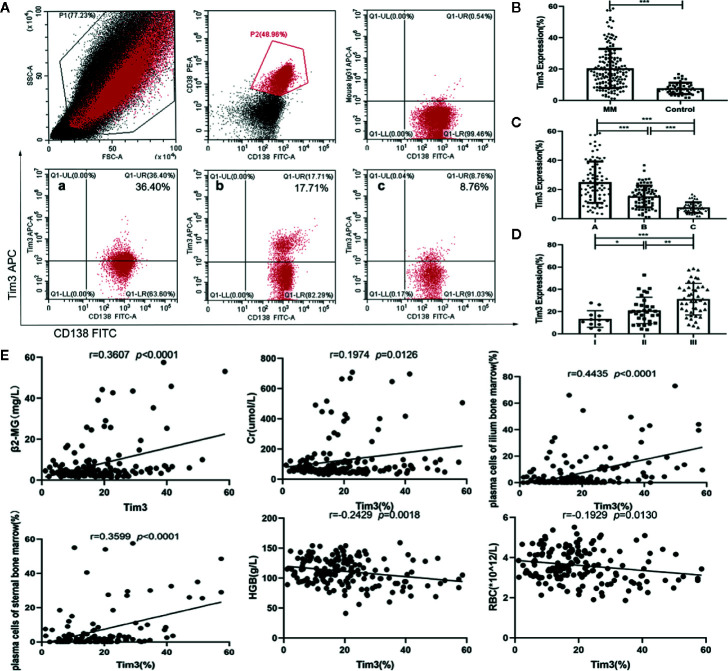
Expression of Tim3 in bone marrow of MM patients and normal healthy people and its clinical correlation analysis. (A) The expression of Tim3 on myeloma cells in MM patients(20.416±12.474%). (a) newly diagnosed patient, (b) patient with VGPR, (c) normal health control. (B) The expression of Tim3 in MM patients and nomal healthy control(7.665±3.592%). (C) The expression of Tim3 in initial treatment/recurrence MM, remission MM and control (25.047±14.185% vs. 15.257±7.454% vs. 7.665±3.592%). (D) The expression of Tim3 in ISS stage I, II, and III (13.338±7.505% vs. 21.023±11.850% vs. 31.167±14.242%). (E) Correlation analysis of Tim3 expression on myeloma cells and clinical indicators in MM patients. Shown are average values with standard deviations. * indicated p<0.05, ** indicated p<0.01, *** indicated p<0.001.